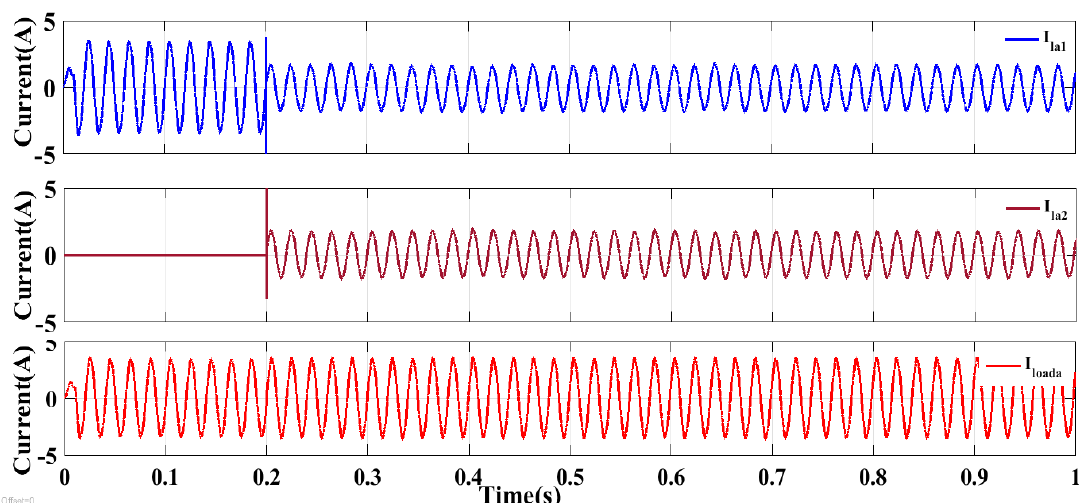
Figure 11. Current sharing during transient operation of parallel inverter.